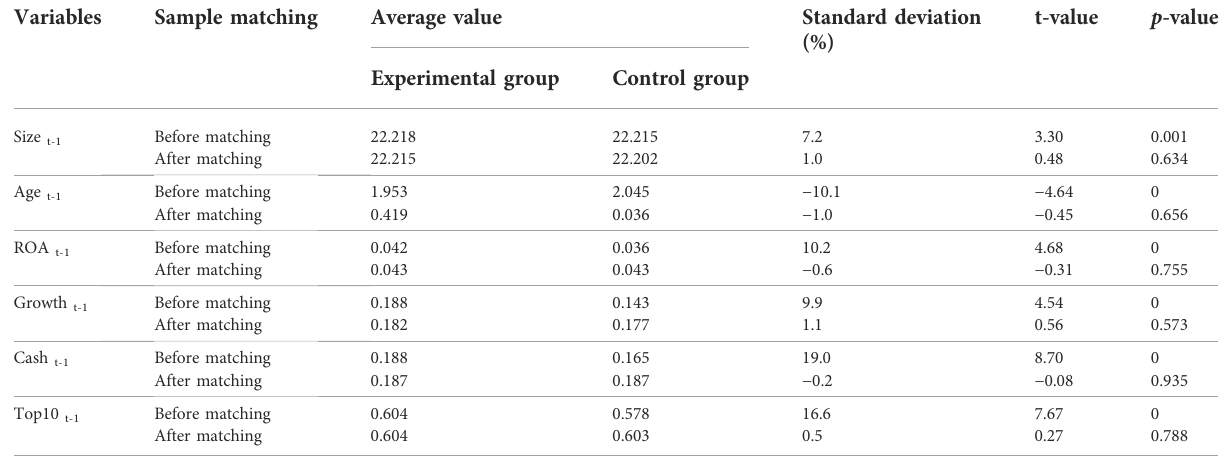
TABLE 6 Covariate balance test.